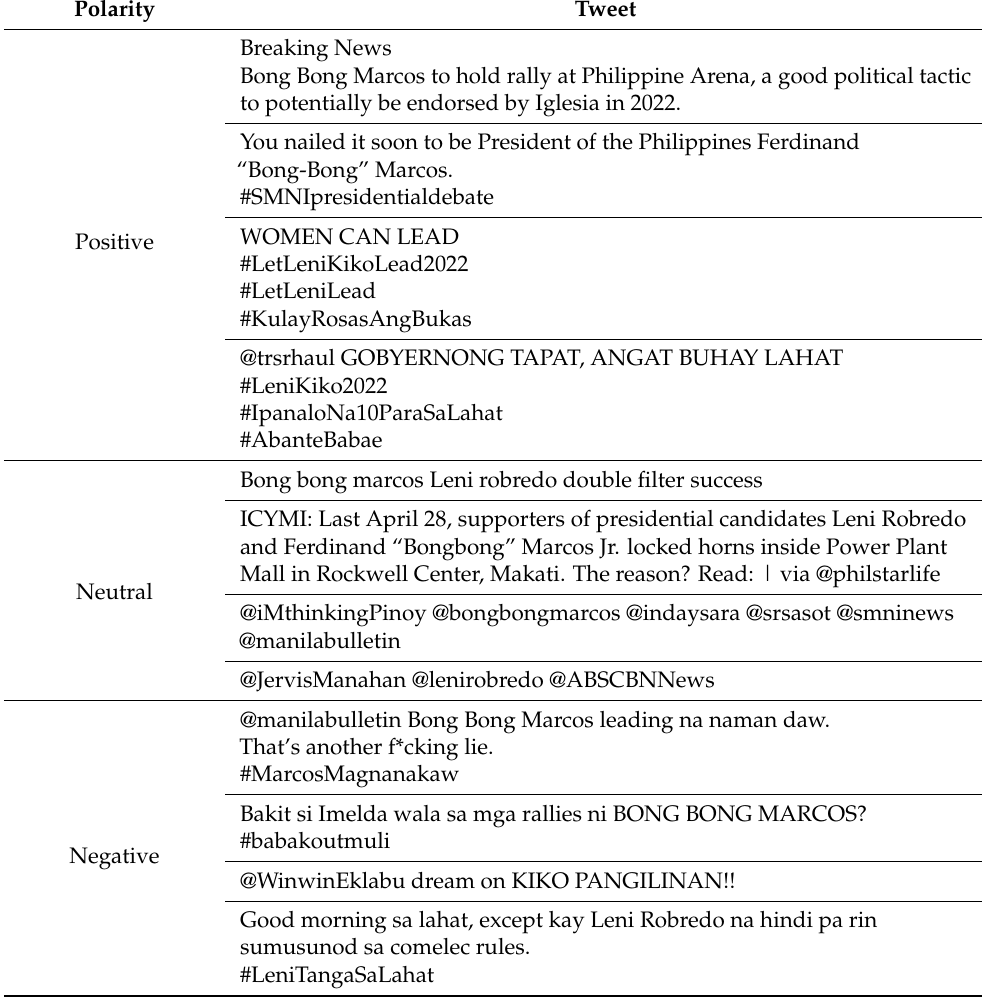
Table 3. Some examples of the tweets annotated by hand.